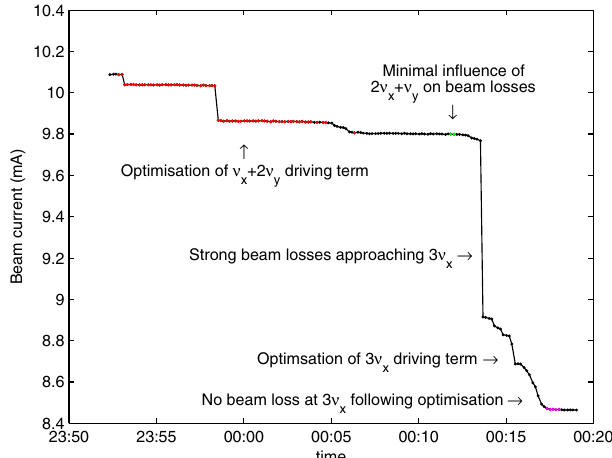
FIG. 10. Relative change in sextupole strengths as a result of the whole optimization.